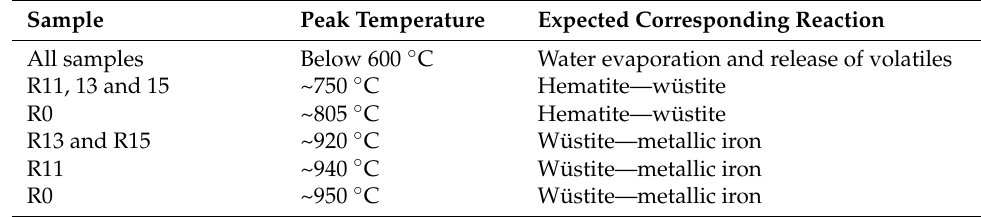
Table 4. The peaks temperature and the corresponding reactions. Sample Peak Temperature Expected Corresponding